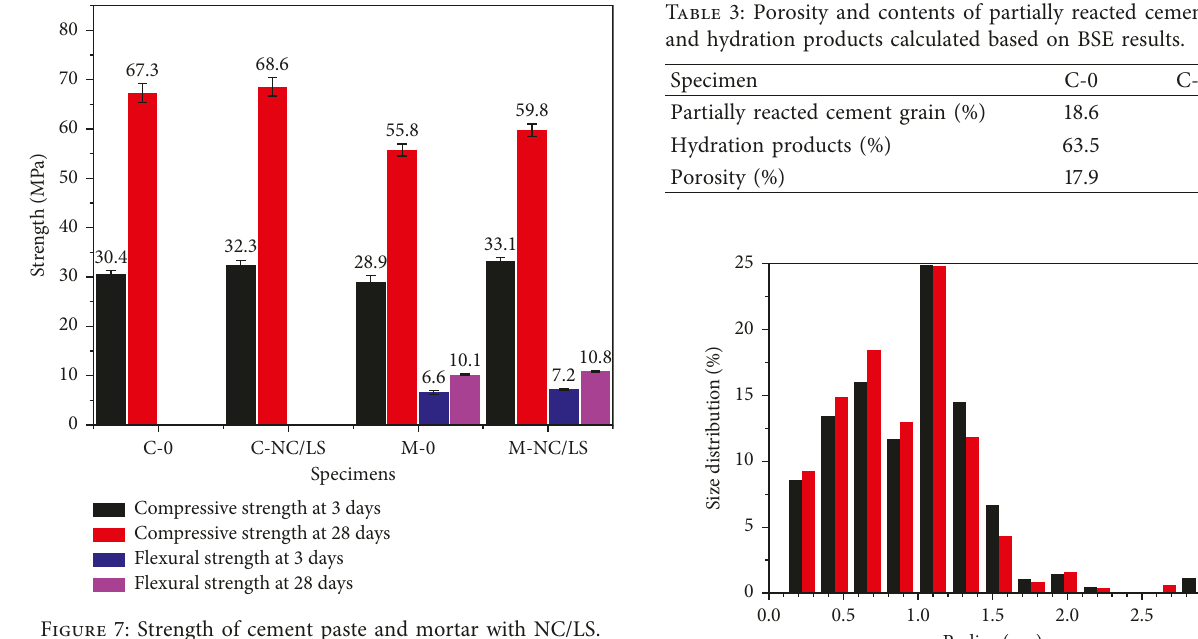
Figure 7: Strength of cement paste and mortar with NC/LS.